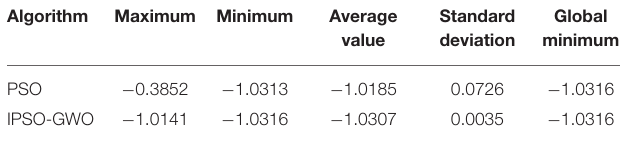
TABLE 10 | Six-Hump Camel function test results.